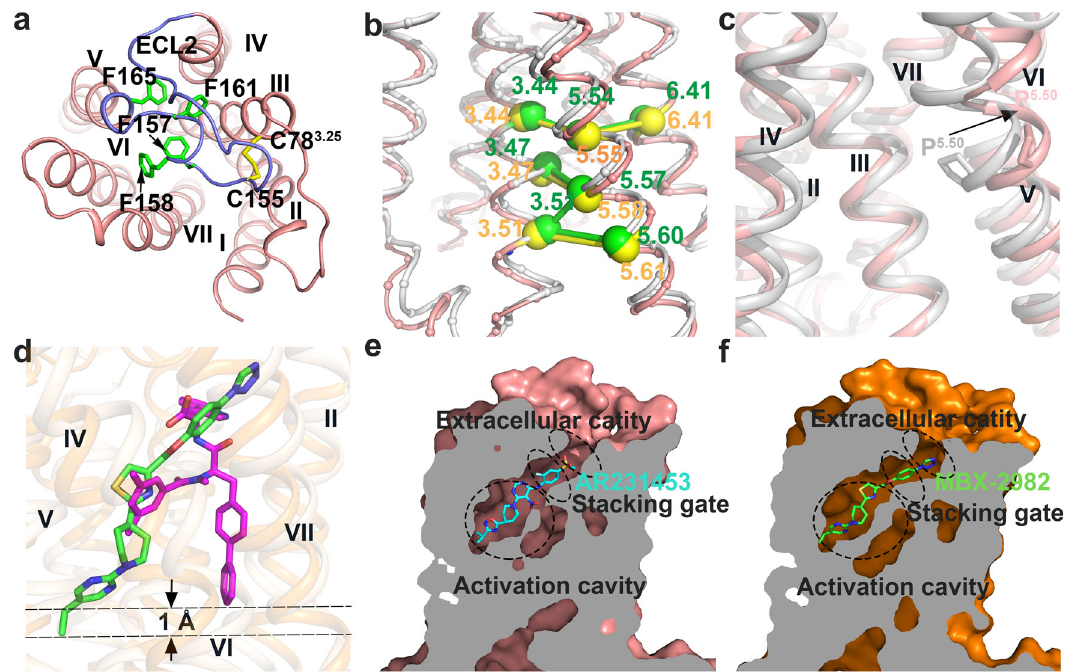
Fig.2|Uniquestructurefeaturesandbindingpocket.a Thesecondextracellular loop (ECL2) of GPR119 in an extracellular view. ECL2 is colored blue. The pheny- lalanines and disul fi de bonds are shown as green and yellow sticks, respectively. b GPR119 displays a noncanonical consensus scaffold of non-covalent contacts in contrast to that of canonical class A GPCRs. GPR119 (pink, this study) and β 2AR (gray, PDB ID: 3SN6) are superimposed with the C α s of the 5 non-conserved inter- TM contacts shown as yellow and green spheres, linked by sticks, respectively. c Theone-aminoacidshiftoftheconservedPro176 5.50 resultsinanoutwardbulgeof TM5. GPR119 (pink, this study) and β 2AR (gray, PDB ID: 3SN6) are superimposed